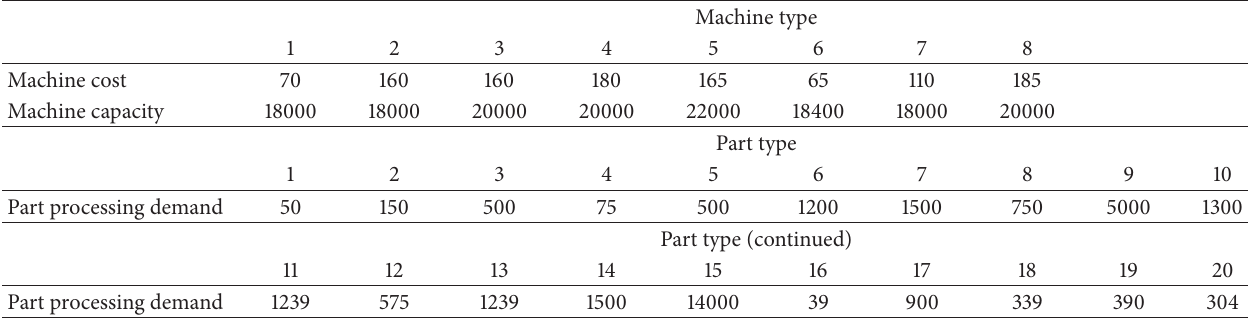
Table 7: Machine cost, machine capacity, and part processing demand for Example